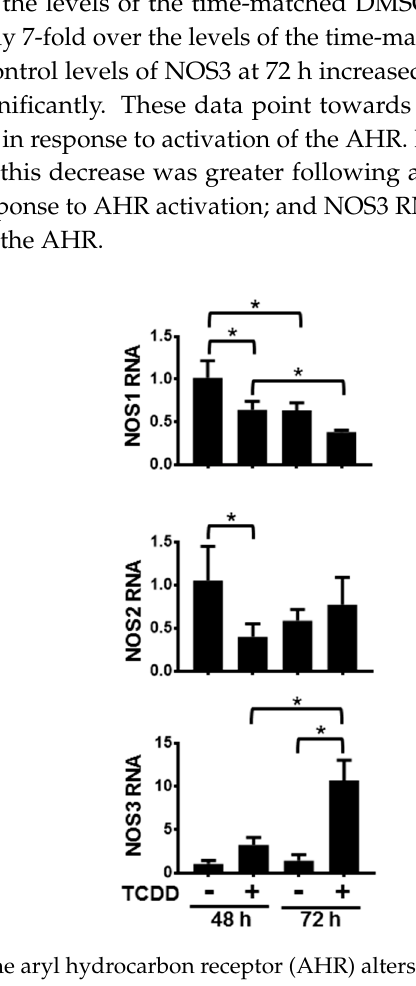
Figure 1. Activation of the aryl hydrocarbon receptor (AHR) alters the levels of NOS1, 2 and 3 RNA. mRNAs from normal human epidermal keratinocytes (NHEKs) treated with dimethyl sulfoxide (DMSO) (0.1%, vehicle) or TCDD (10 nM) for the indicated times were measured. Levels (mean ( n = 4) +/ - SD) were normalized with TATA binding protein (TBP) and plotted relative to DMSO (48 h), set to a value of one. * indicates a significant di ff erence, p < 0.05. Data were analyzed using two-way ANOVA followed by Tukey’s post hoc tests.